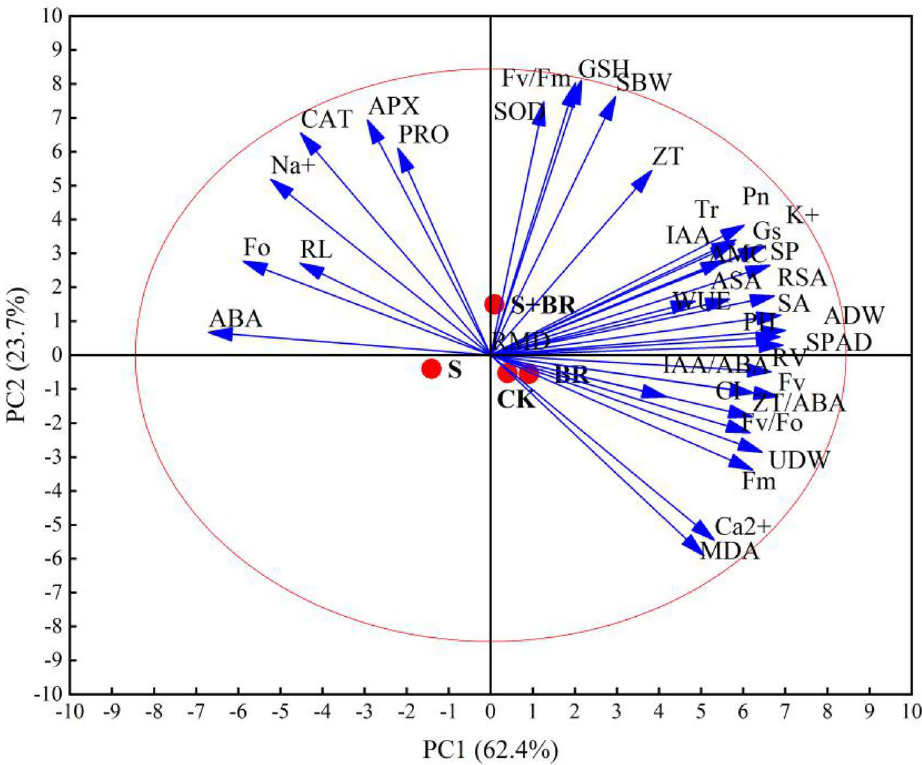
Figure 13. Principal component analysis among the indicators measured of rice seedlings. ADW aboveground dry weight, UDW underground dry weight, RL root length, RSA root surface area, RV root volume, PH plant height, SBW stem width, Pn net photosynthetic rate, Gs stomatal conductance, Tr transpiration rate, Ci intercellular carbon dioxide concentration, SP soluble protein, Pro proline. CK: soaking with distilled water + watering 0 g L −1 NaCl. S: soaking with BR + watering 0 g L −1 NaCl. BR: soaking with distilled water + watering 3 g L −1 NaCl. S + BR: soaking with BR + watering 3 g L −1